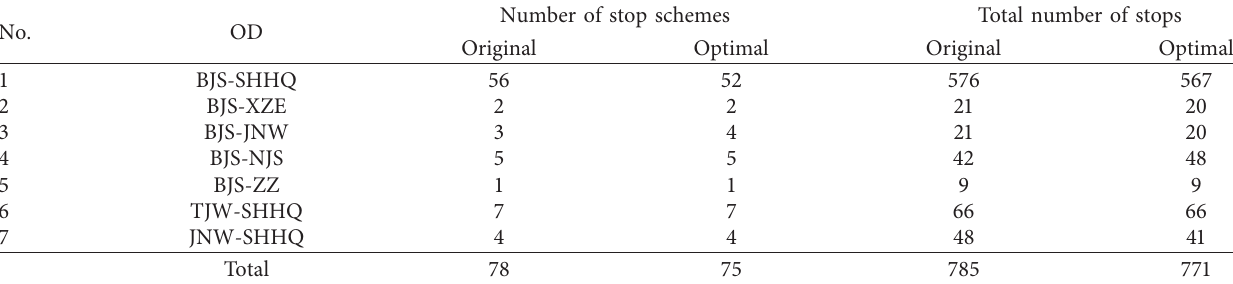
Table 5: Stop plan